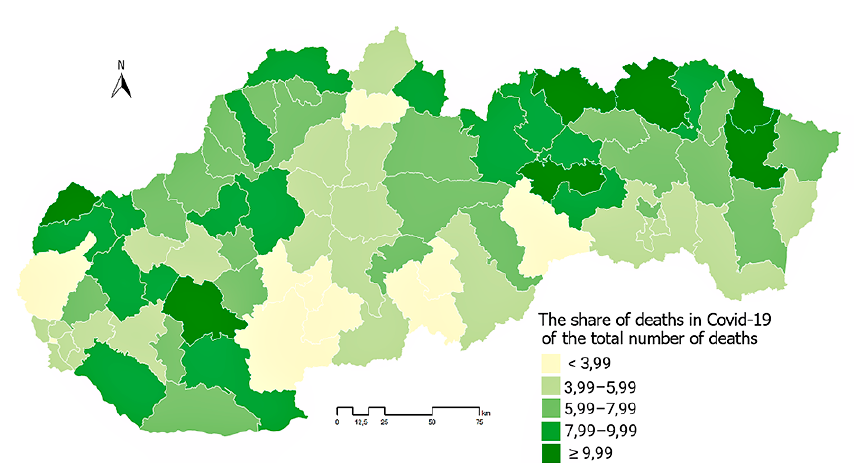
Figure 12. Share of deaths attributed to Covid-19 in districts of Slovakia in